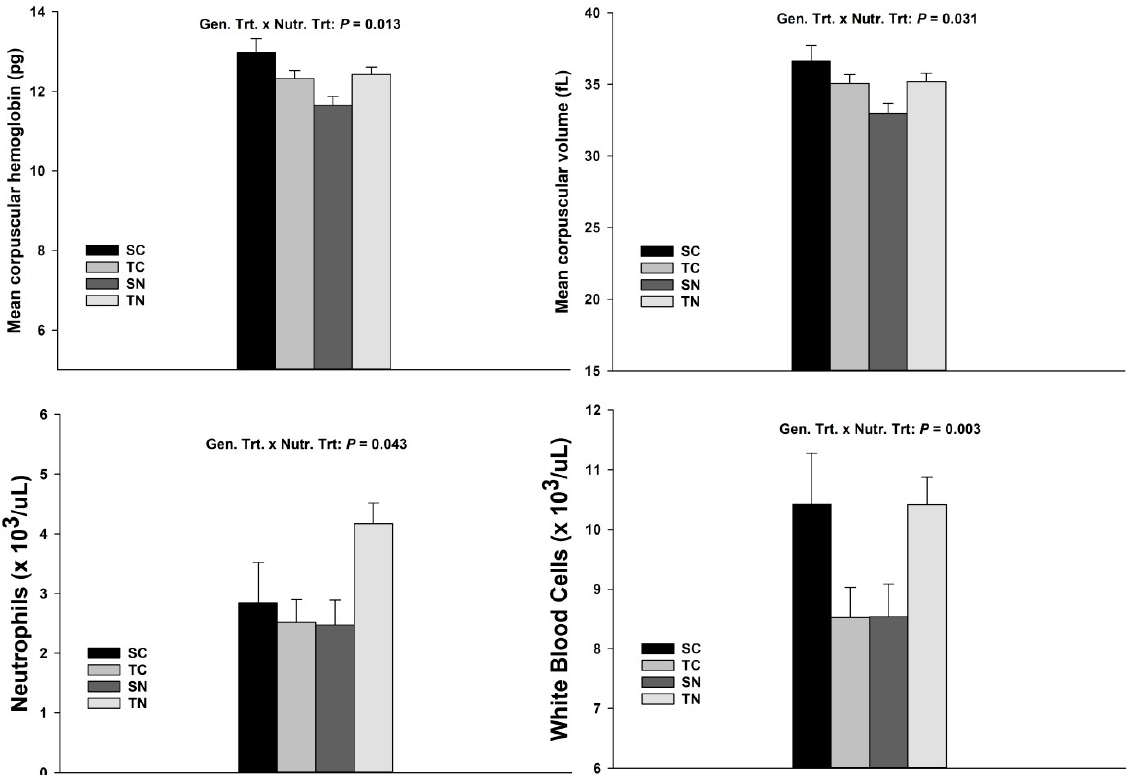
Figure 3. Significant genetic treatment and nutritional treatment interactions for mean corpuscular hemoglobin, mean corpuscular volume, neutrophils, and white blood cells of Angus × Simmental steers and heifers offspring. Mean